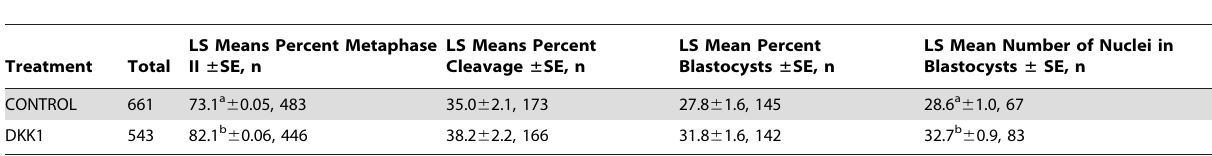
Table 2. Maturation of oocytes in the presence or absence of DKK1 (data represents four replications).